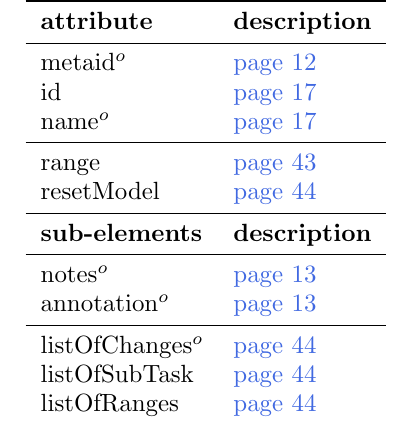
Table 2.20 shows all attributes and sub-elements for the repeatedTask element.